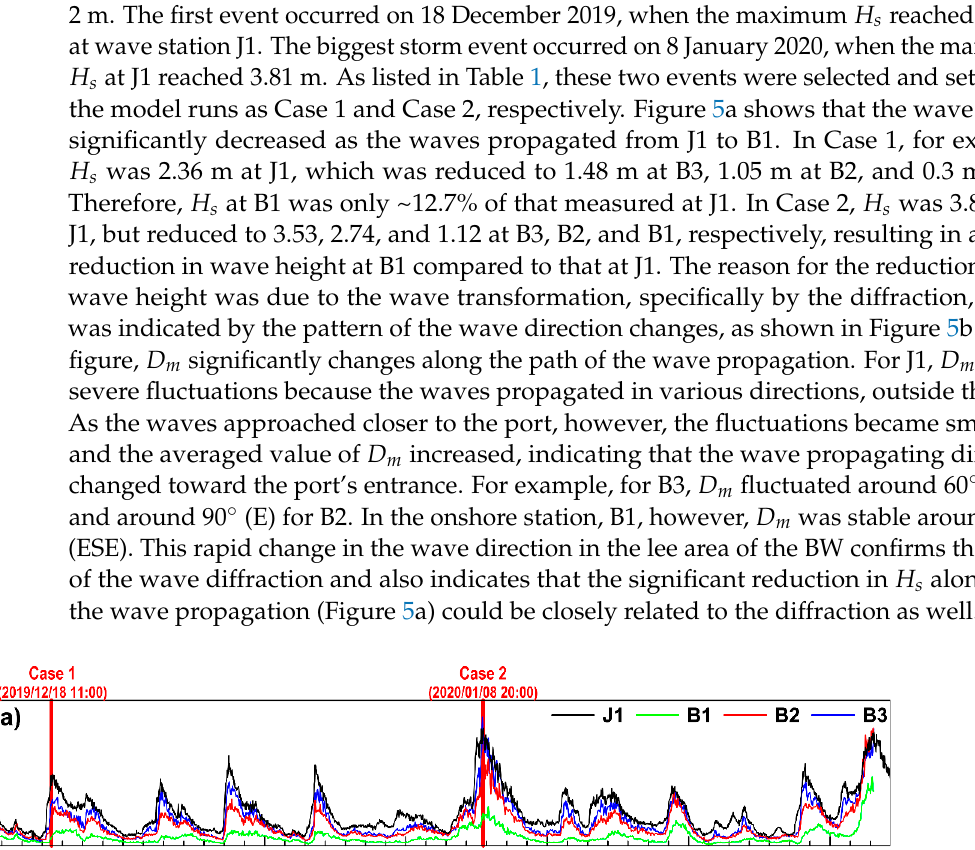
8 of 19 Table 1. List of wave parameters used as the forcing (boundary) conditions for both models in the two runs of Case 1 and Case 2. The model input data were determined based on the measurements during the field experiment. Model Runs Time of Wave Measurement